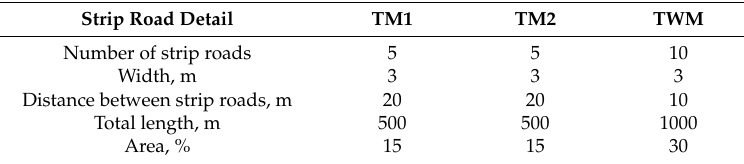
Table 10. Strip road area, calculations per one